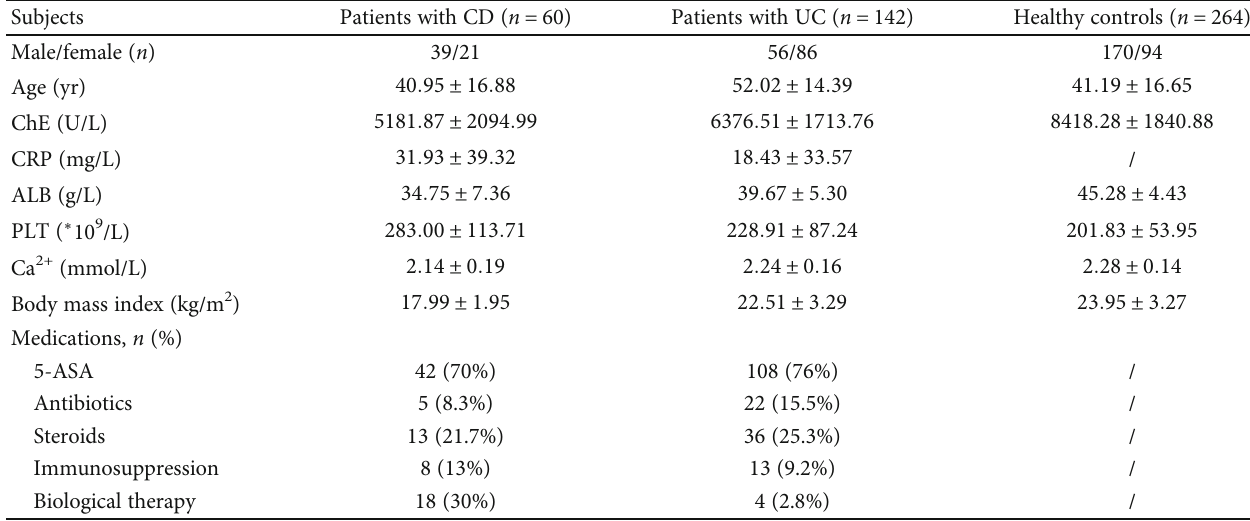
Table 1: Characteristics of patients with IBD and HCs.